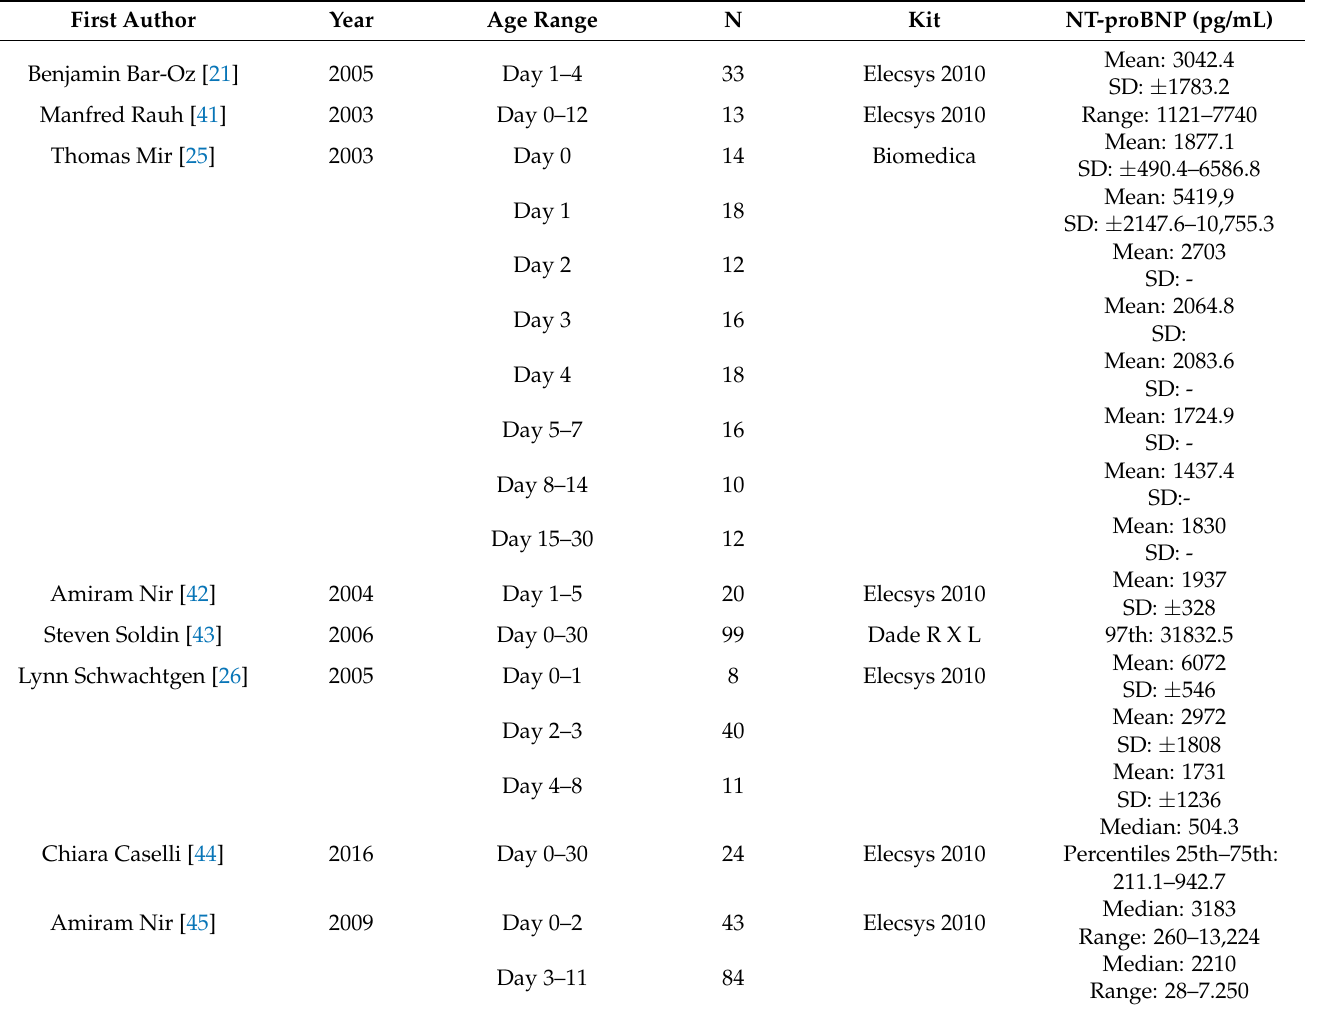
Table 2. Characteristics and results of included studies that report on the values of NT-proBNP in serum of healthy term neonates (N = 15). N/A: NOT